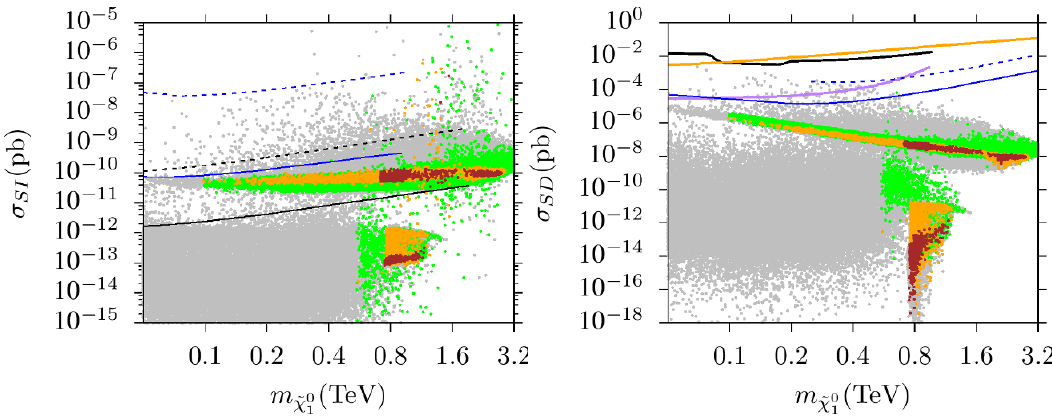
Figure 9 . Spin-independent (left) and spin-dependent (right) scattering cross-sections versus the LSP neutralino mass. In the (cid:27) SI (cid:0) m plane, the dashed (solid) blue line represents the current ~ (cid:31) 0 1 (future) results from the SuperCDMS experiment [101]. The dashed (solid) line indicates the current (future) results from the LUX-Zeplin experiment [102]. In the (cid:27) SD (cid:0) m plane, the solid black line ~ (cid:31) 0 1 represents the currrent bound from Super-K [103], while the orange solid line is set by the LUX results [104]. The purple line is obtained from the collider analyses [105]. The dashed (solid) blue line shows the current (future) results from IceCube